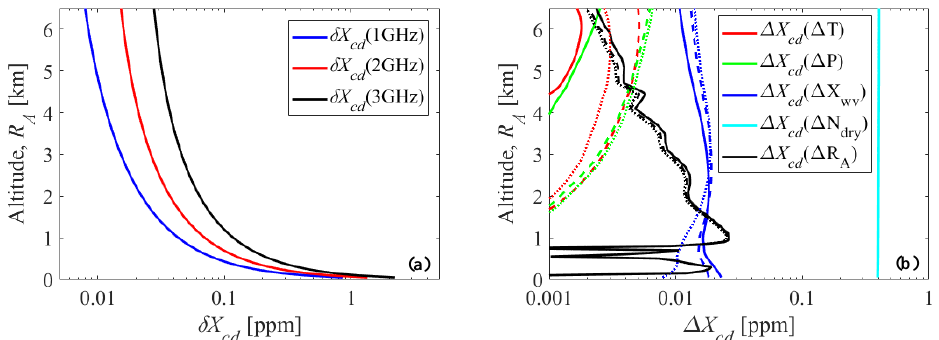
Figure 11. Estimated XCO 2 ( a ) random error, δX cd , and ( b ) systematic error, Δ X cd , variation with altitude for the 2-μm IPDA lidar. δX cd is modeled using MCT e-APD detection channel set at 10 V bias and assuming full dynamic range return signals for achieving maximum SNR and 500 shot (10-s) average. Δ X cd is modeled assuming ΔT = ± 10 K, ΔP = ± 750 Pascal, Δ x wv = ± 1000 ppm and Δ R C = ± 10 m for atmospheric and ranging error sources using 1 GHz (solid), 2 GHz (dashed) and 3 GHz (dotted) on-line wavelengths.